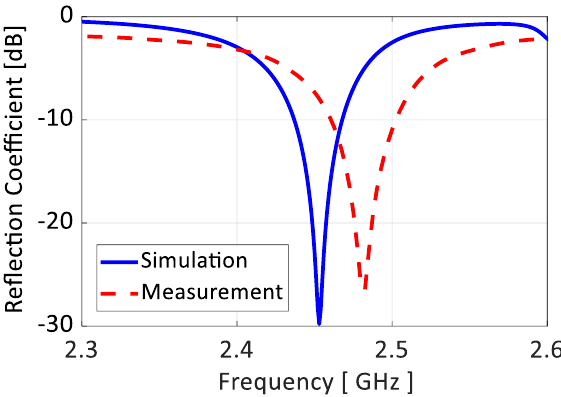
Figure 4. Simulation and measurement results of the reflection coefficients of the proposed antenna.